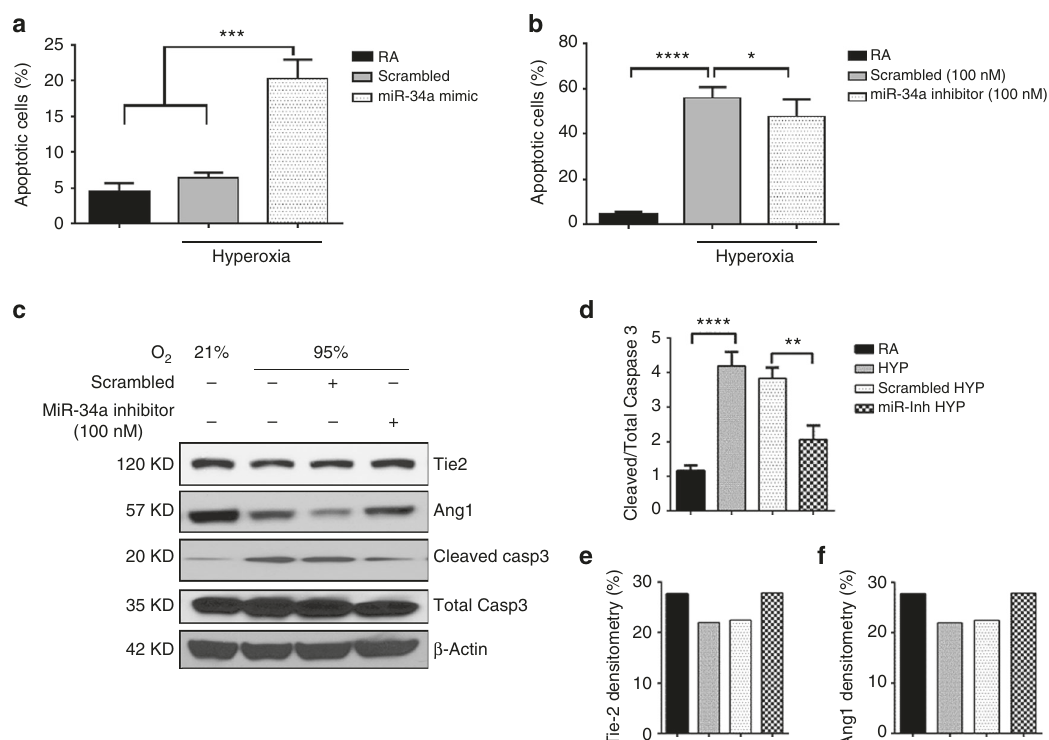
Fig. 4 miR-34a increases apoptosis in lung epithelial cells. a MLE12 cells were transfected with either the N.C. mimic or miR-34a mimic and exposed to hyperoxia for 48 h and subjected to Annexin V and Propidium Iodide (PI) assay. Graph showing signi fi cantly increased FACS analysis of Annexin V and PI staining positive cells in miR-34a mimic transfected group compared to its control. b Representative graph showing signi fi cantly deccreased Annexin V and PI staining positive cells in miR-34a inhibitor transfected group compared to its control in hyperoxia exposed MLE12 cells. c Western blot image showing increased Tie2 and Ang1 and decreased cleaved caspase 3 in miR-34a inhibitor transfected group compared to its control in hyperoxia exposed MLE12 cells. d Densitometric analysis showing signi fi cantly decreased ratio of cleaved caspase 3 to total caspase 3. e Densitometric analysis showing increased Tie2 ( n = 1). f Densitometric analysis showing increased Ang1 ( n = 1). Values are means + SEM of a minimum of four experiments, unless otherwise